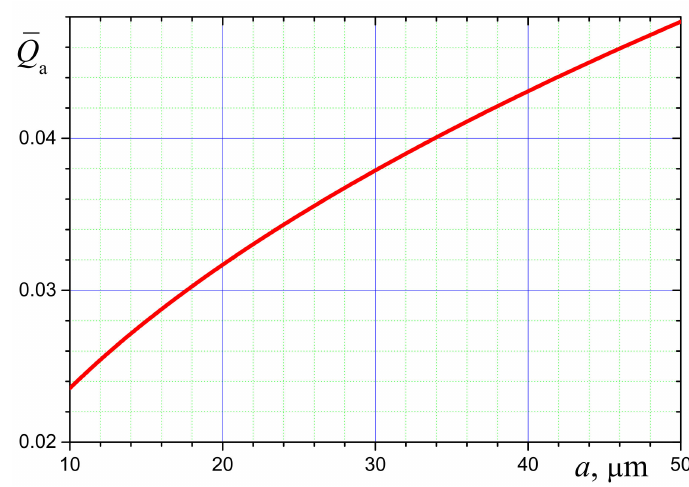
Figure 5. The average e ffi ciency factor of absorption vs. the droplet